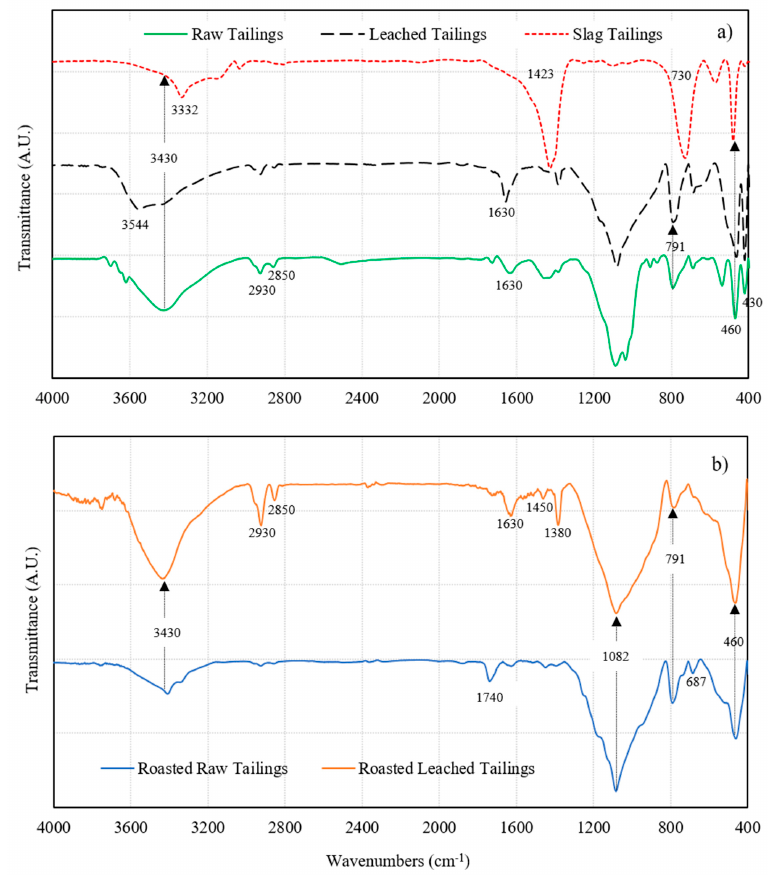
Figure 5. FTIR spectrum of ( a ) raw-leached-slag tailings ( b ) roasted raw-leached tailings.